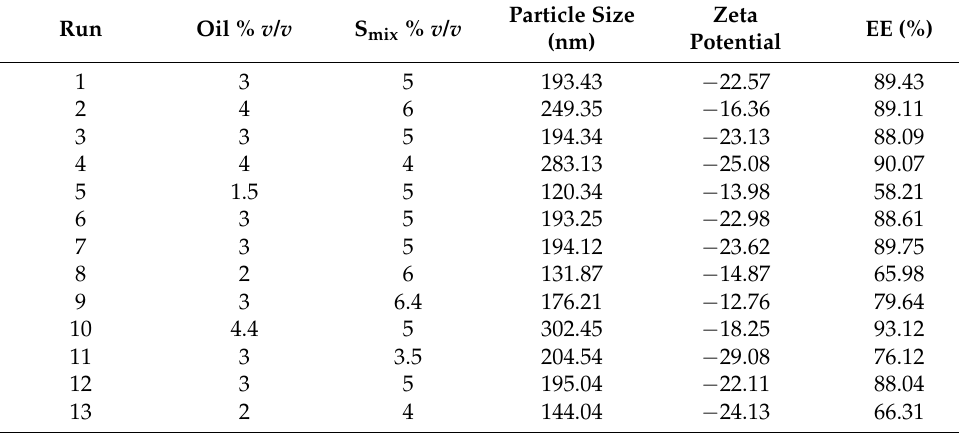
Table 1. Responses obtained using